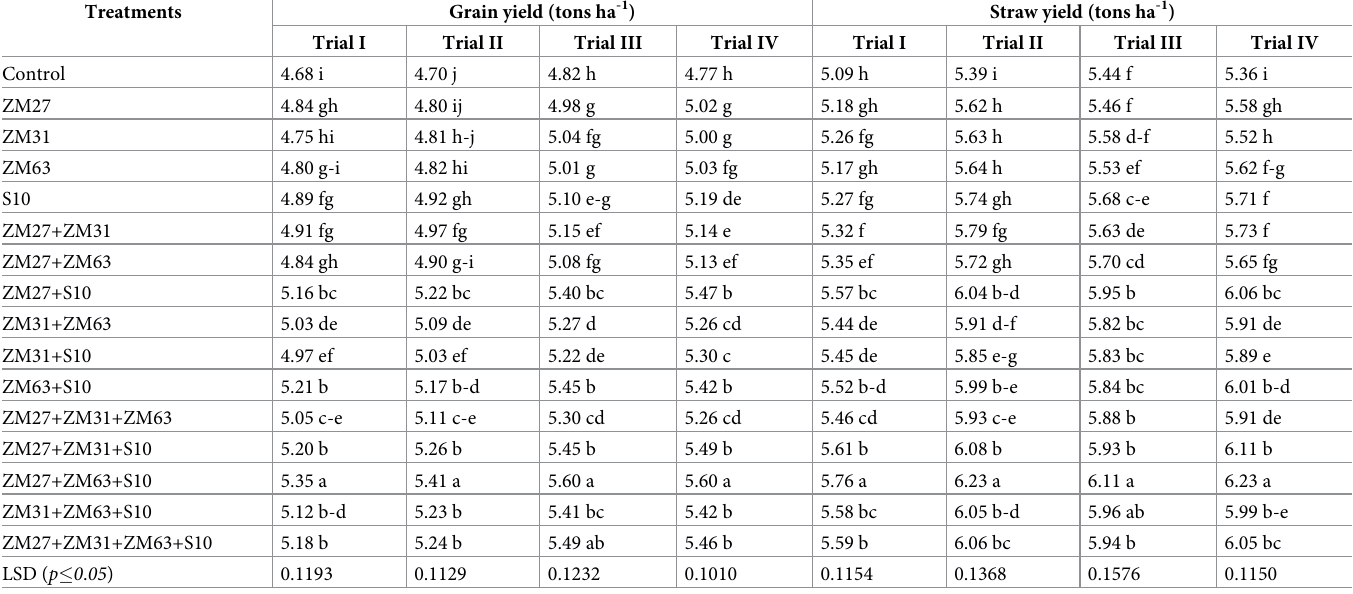
Table 4. Effects of novel bio-inoculants on grain and straw yield of wheat in a field trial. Treatments